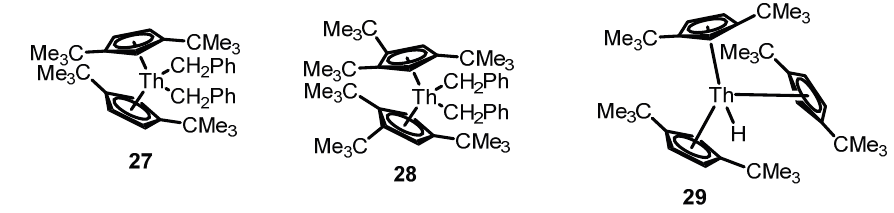
Figure 9. Thorium metallocenes used as pre-catalysts for the ROP of rac-lactide